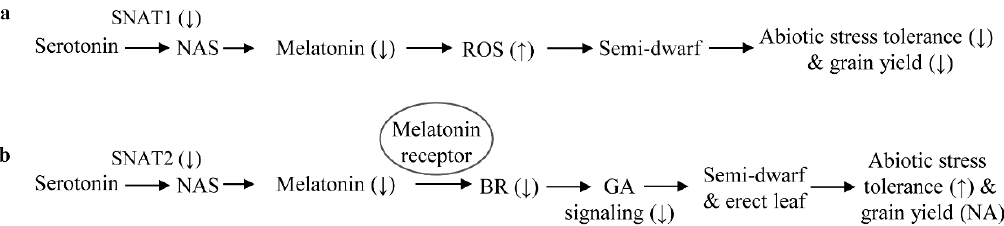
Figure 10. A proposed mechanism for melatonin-mediated abiotic stress tolerance. Two different mechanisms underlie melatonin-mediated plant responses. One mechanism is a BR-independent pathway ( a ). This pathway is associated directly with the antioxidant activity of melatonin. Melatonin-deficient rice plants, such as snat1 , produce increased levels of reactive oxygen species (ROS), which in turn inhibit plant growth and dampen abiotic stress tolerance. The other mechanism is a BR-dependent pathway ( b ). This pathway involves melatonin as a signaling molecule, possibly